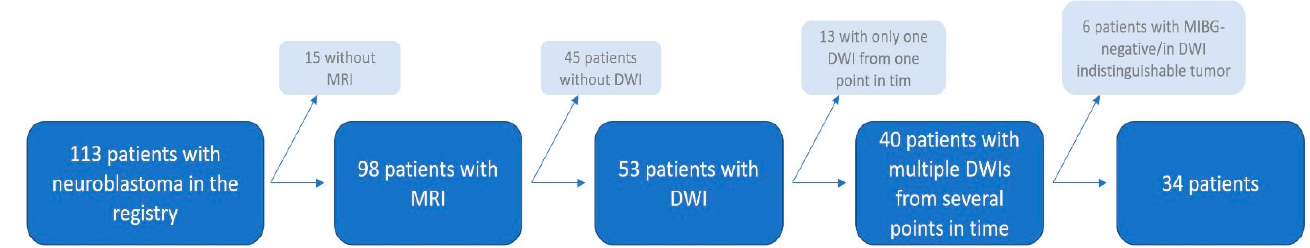
Figure 2. Flow chart illustrating the patient collective and the excluded patients. The youngest patient was 12 months old at the time of the first imaging, and the oldest patient was 26 years old. (Average age at the time of the initial examination 6.8 ± 5.8 a.) Twenty-seven patients had INSS stage IV neuroblastoma, and seven had INSS stage III